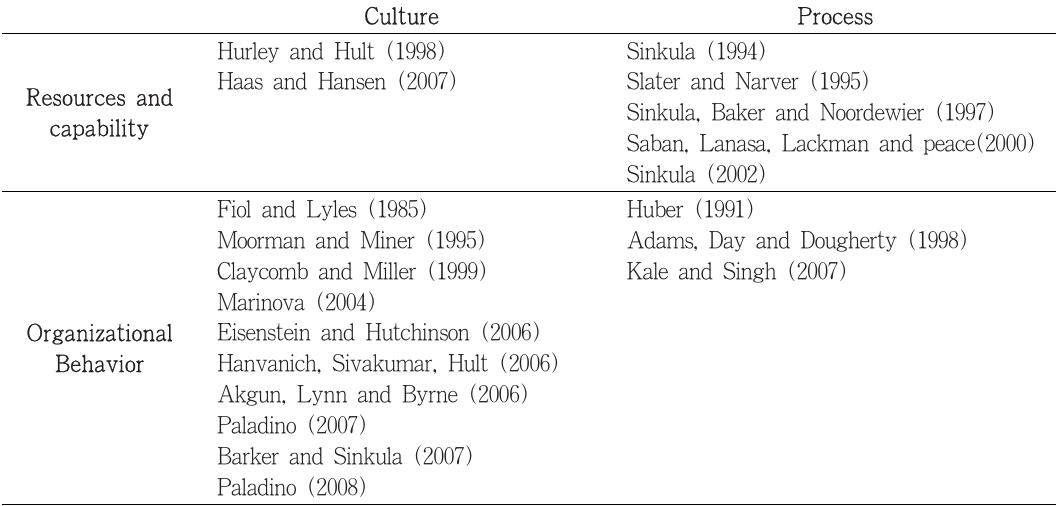
<Table 1> Different Perspective of the